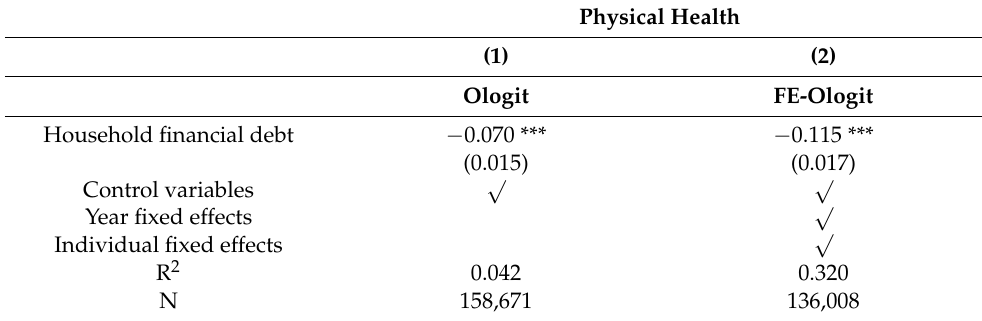
Table 3. Ordered logistic regression results.